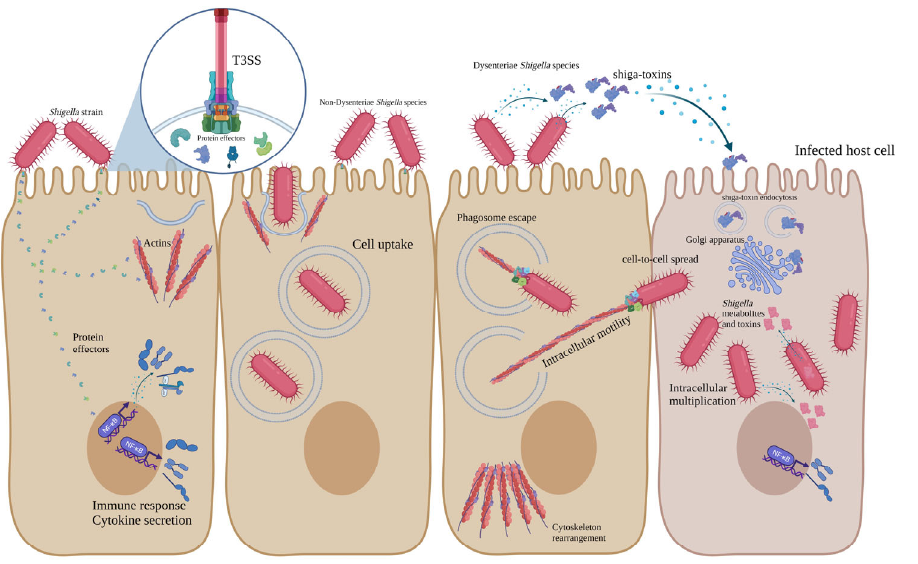
Figure 1. Schematic representation of pathogenesis mechanisms of Dysenteriae and non-Dysenteriae species of Shigella .